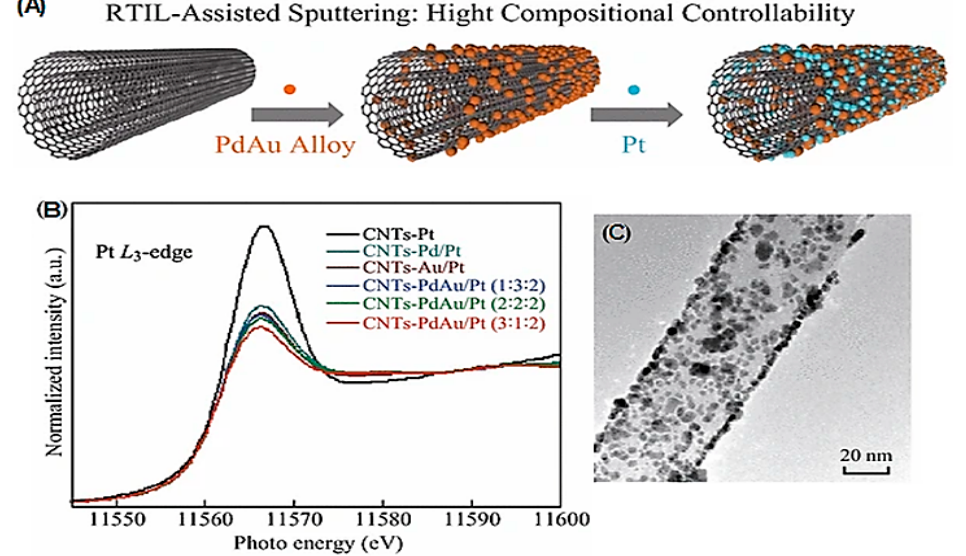
Figure 1. ( A ) The process of CNTs ‐ PdAu/Pt NPs preparation, ( B ) Pt L 3 ‐ edge X ‐ ray absorption near edge structure (XANES) spectra of CNTs ‐ supported PdAu/Pt trimetallic NPs, ( C ) TEM image of CNTs ‐ PdAu/Pt NPs, Adapted from [76], (CC BY 4.0).